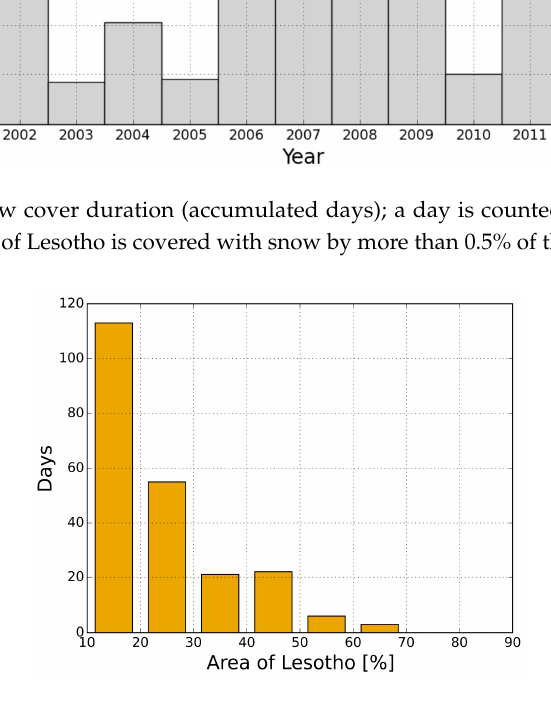
Figure 10. Absolute numbers of days with snow cover (in %) between 2000 and 2014; e.g., snow coverage of 30%–40% was observed for 23 days between 2000 and 2014.